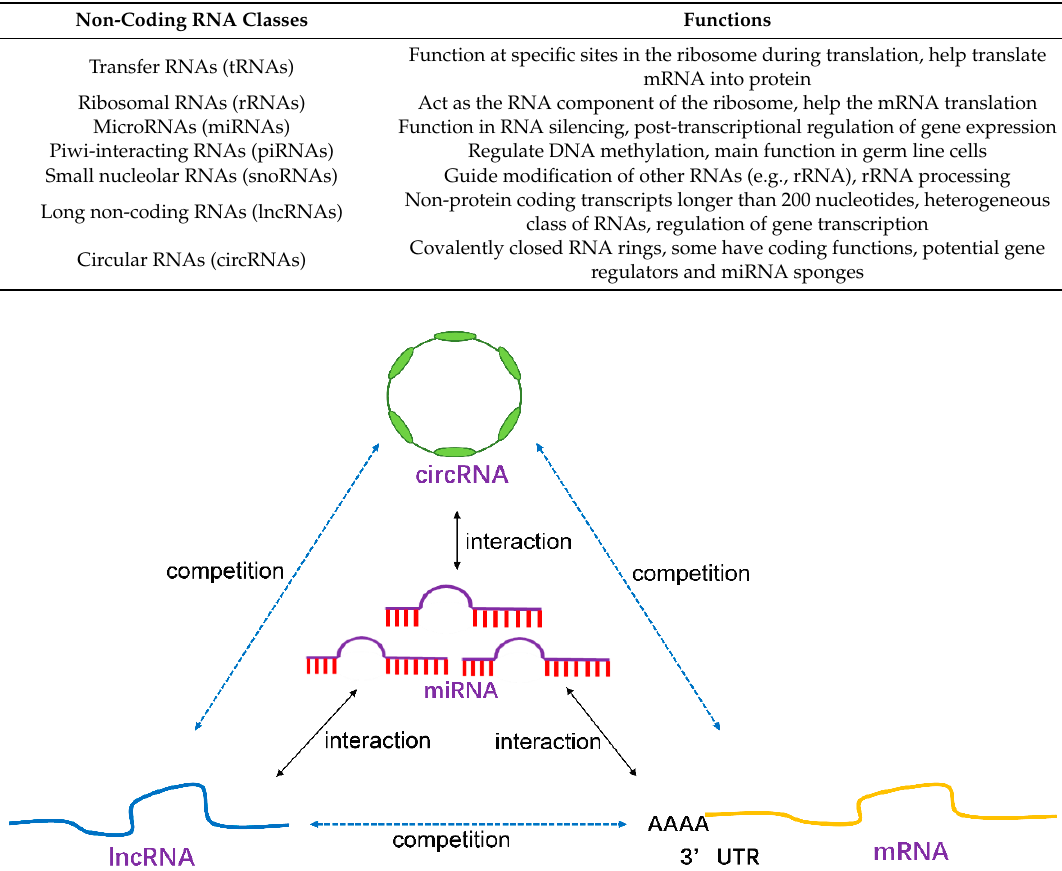
Table 1. Non-coding RNA classes and their functions.